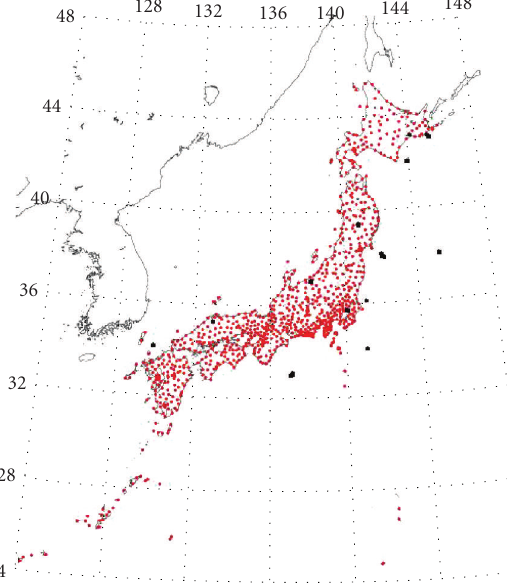
Figure 1: Location of GEONET receivers (red spot) and the epicenter of 18 earthquakes in Table 1 (black sopt). The epicenters of some earthquakes are not in the range of GPS network (see black spots); however, the TEC anomaliesassociated with the earthquakes can be detected, because the TEC anomalies are wider for lage earthquakes [1,